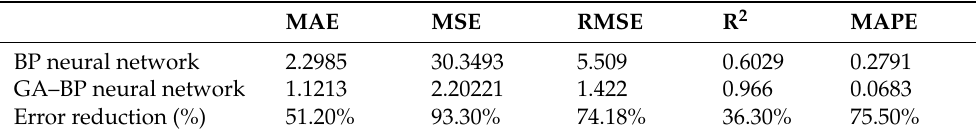
Table 2. BP and GA–BP neural network error